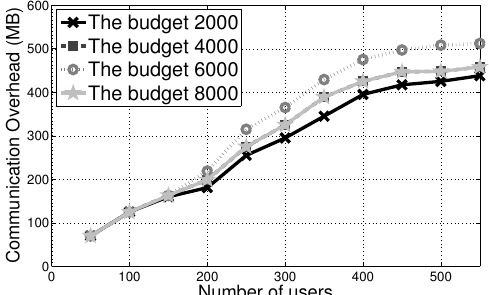
Figure 5. Communication overhead of PVI-H with different